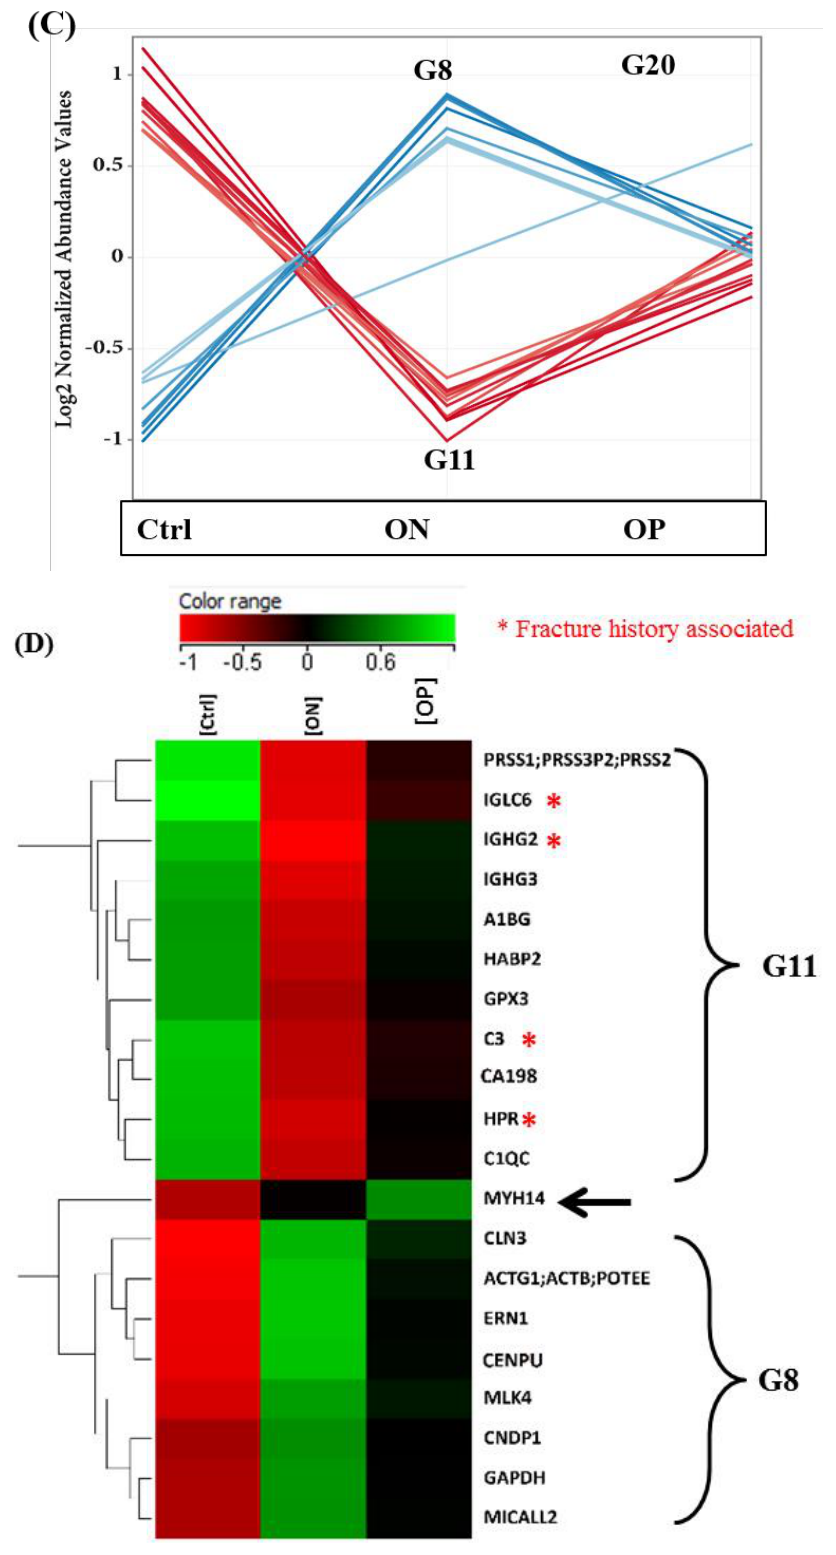
Figure 2. Proteomics profiling between healthy control (Ctrl), osteopenic (ON), and osteoporotic (OP) patients. ( A ) Orthogonal partial least squares-discriminant analysis (OPLS-DA) cross-validation illustrates the significant differences between the three study groups (Ctrl, ON, OP) (Q 2 = 0.7295, and R 2 = 0.9180). ( B ) Venn diagram demonstrating the significantly dysregulated proteins between Ctrl vs. ON ( n = 65), Ctrl vs. OP ( n = 34), and ON vs. OP ( n = 51), considering FC of 1.5 and p value of 0.05. Also shown is the identification of common and significant proteins ( n = 20) be- tween the three study groups. ( C ) Levels of commonly dysregulated proteins (G20) among the three groups, where G8 were upregulated to the highest abundance in the ON group, compared to that in the control group and then downregulated in the OP group, compared to that in the ON group, while G11 was downregulated to the lowest abundance in ON, compared to that in control and then upregulated in OP compared to that in ON. ( D ) Heat map showing the identity and ex- pression levels of the 20 significantly detected proteins among the three study groups and also